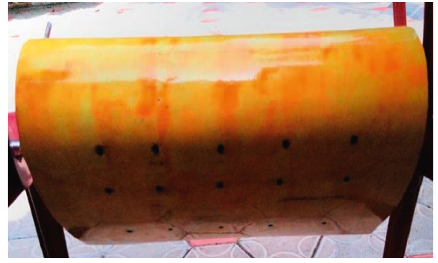
Figure 17: Airfoil wooden